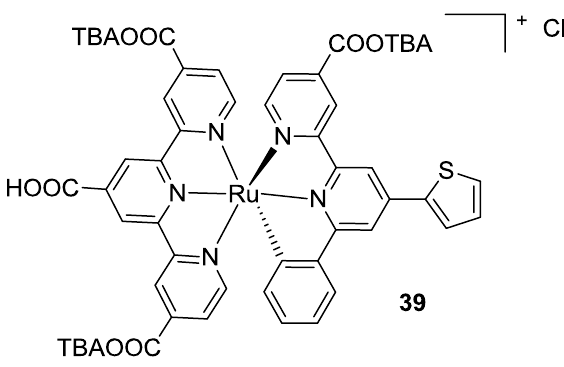
Figure 29. Bis-tpy-based Ru(II) complex proposed by Kisserwan et al. [135].